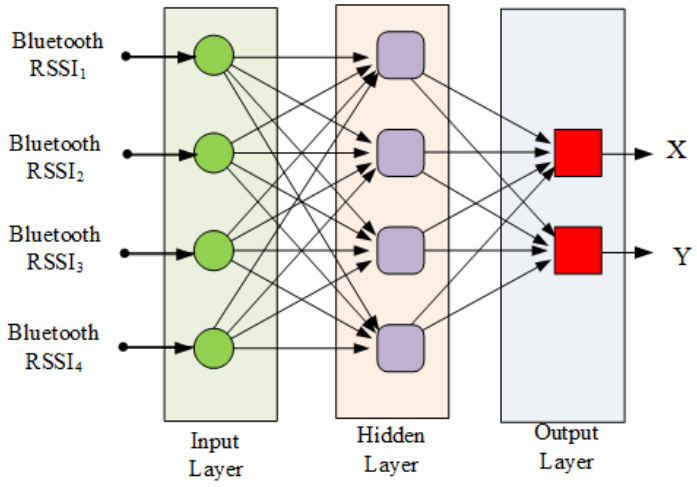
Figure 6. Structure of feedforward multilayer perceptron artificial neural networks (FF-MLP ANN) used to calculate the X and Y positions.